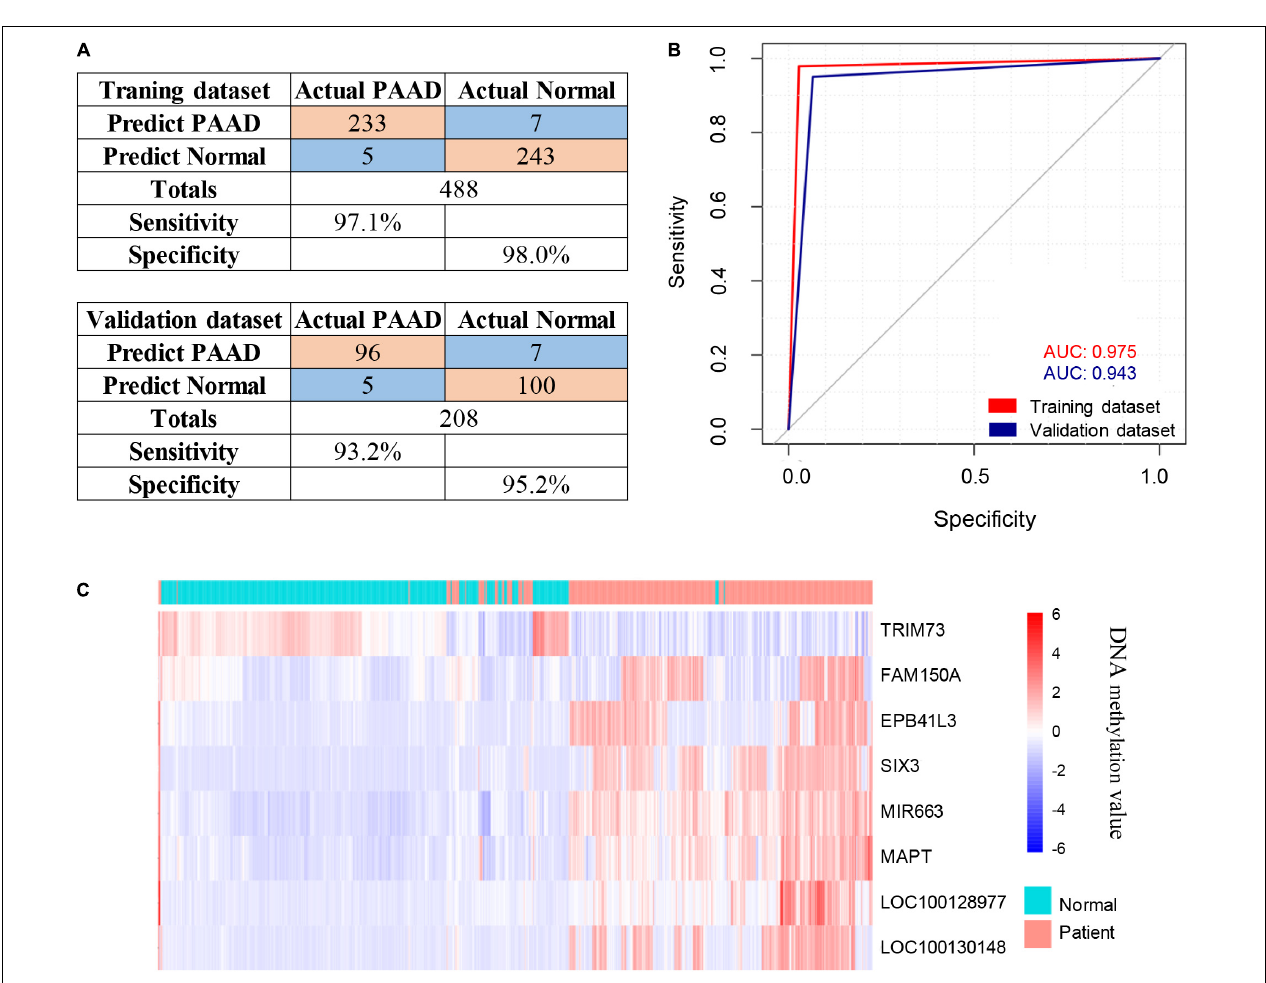
FIGURE 6 | Identification of novel pancreatic cancer diagnostic markers from cfDNA methylation analysis. (A) Confusion tables of binary results of the diagnostic prediction model in the training and validation datasets. (B) ROC of the diagnostic prediction model with methylation markers in the training and validation datasets. (C) Unsupervised hierarchical clustering of the eight methylation markers selected for use in the diagnostic prediction model.